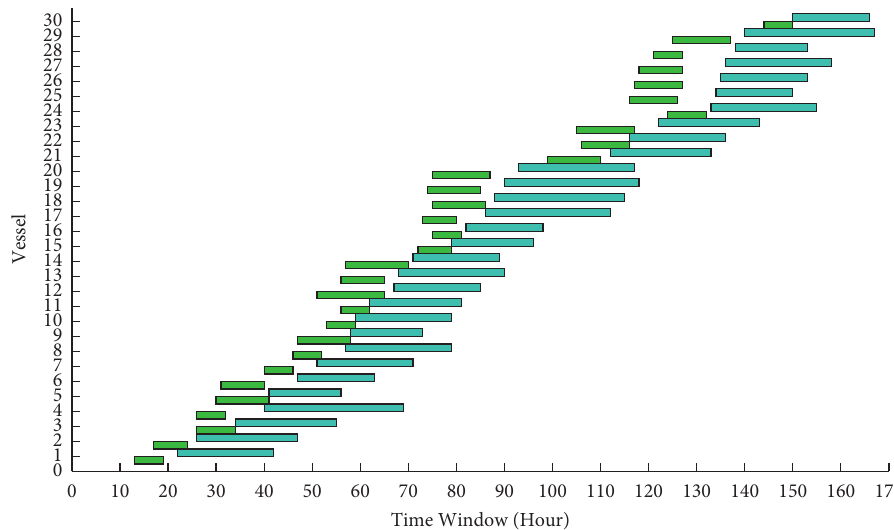
Figure 12: The optimized arrival time windows of the external